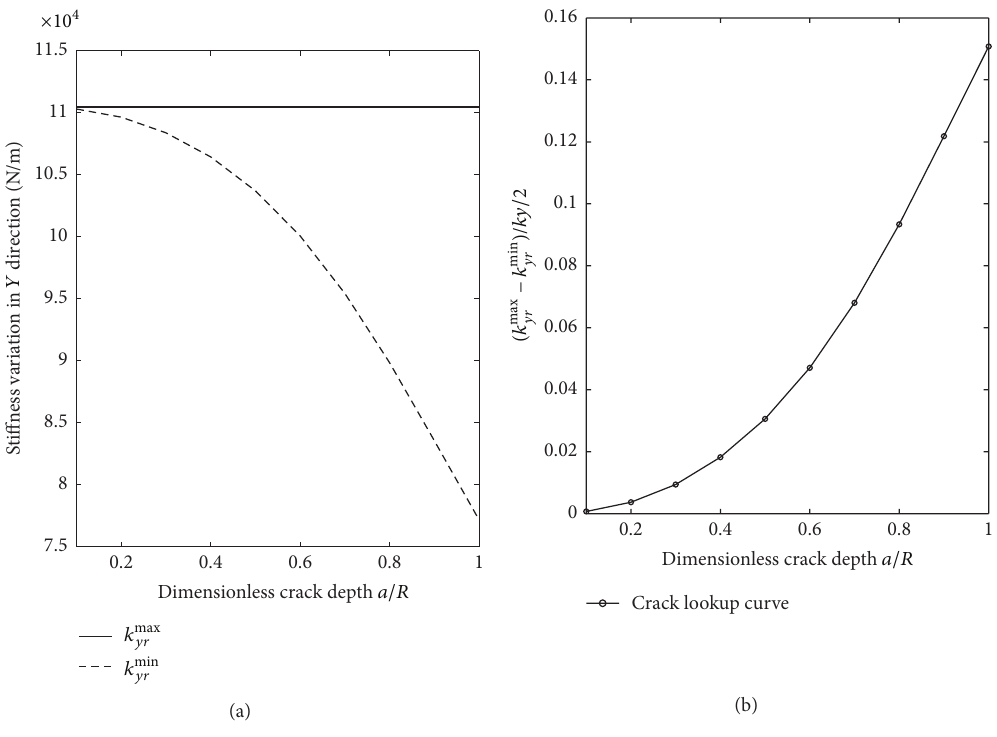
Figure 6: Stiffness variation versus crack depth in 𝑦 direction of rotating frame.